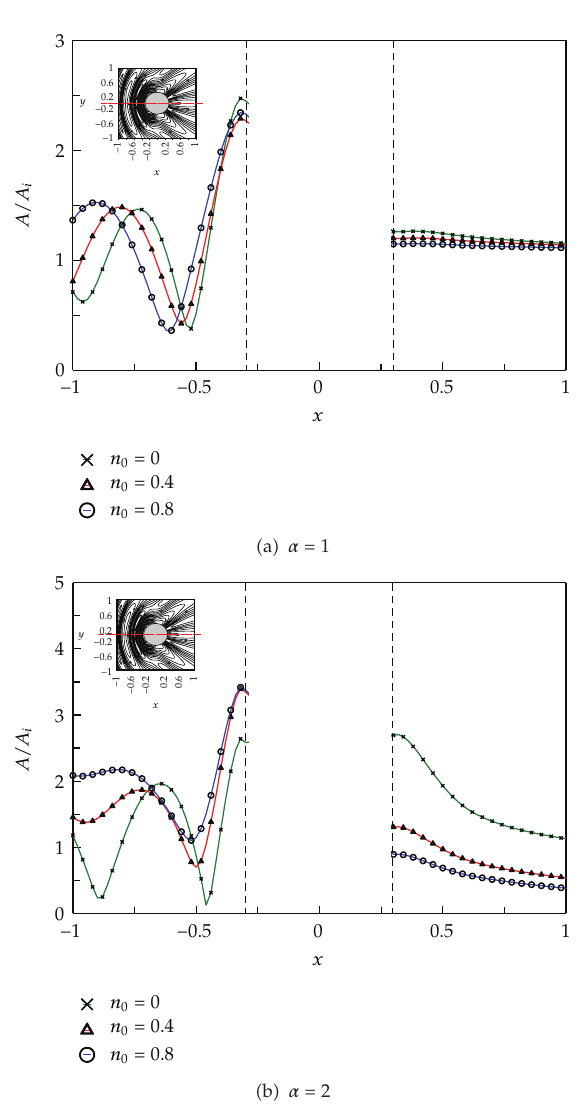
Figure 2: E ff ects of the porosity of the permeable material (cid:2) ρ 0 (cid:4) 0 . 2 π , ρ 1 (cid:4) 0 . 1 π , f p (cid:4) 1 (cid:3) .